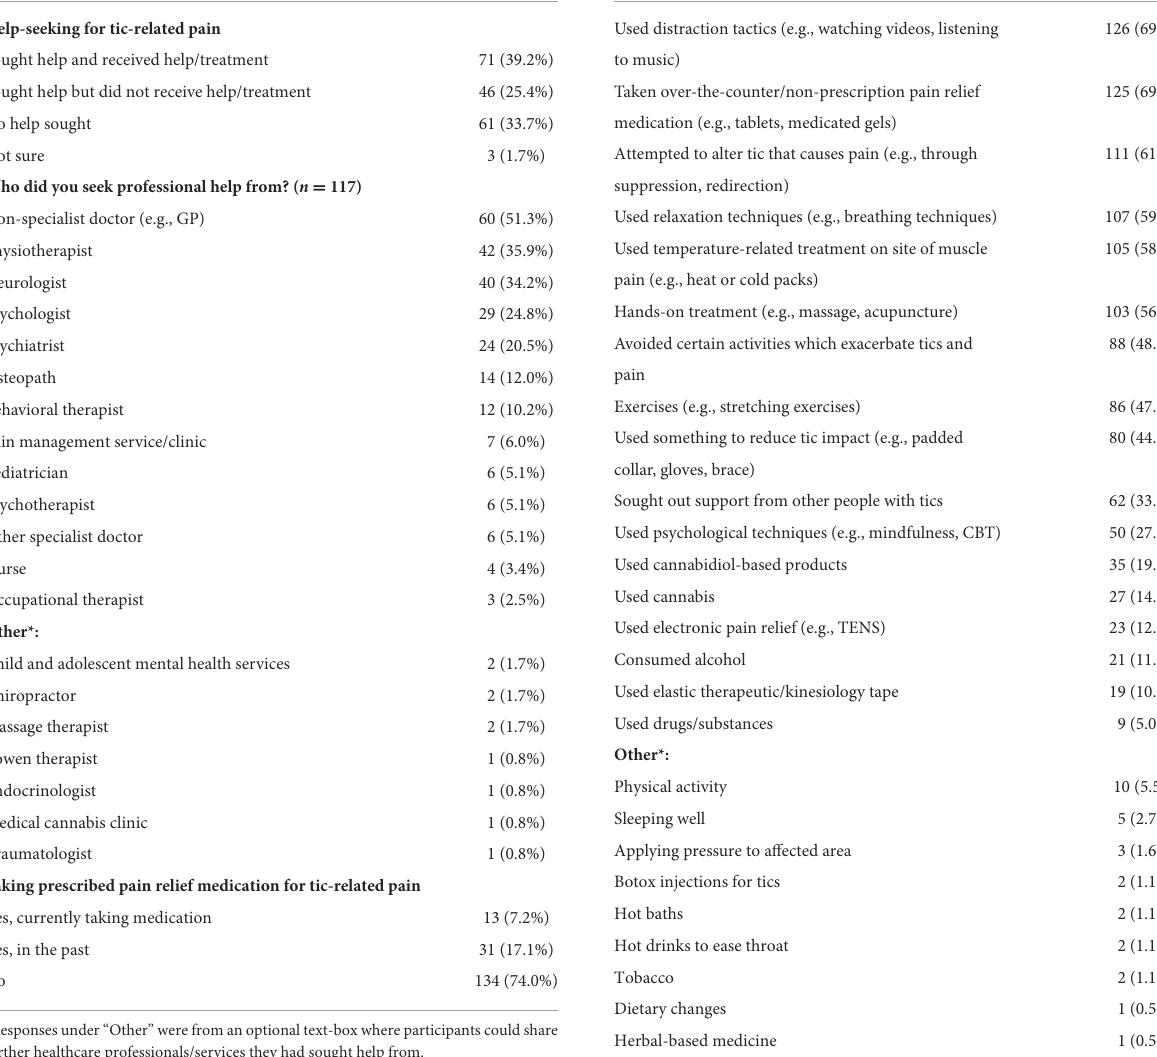
TABLE 5 Self-reported help-seeking from healthcare professionals for tic-related pain.